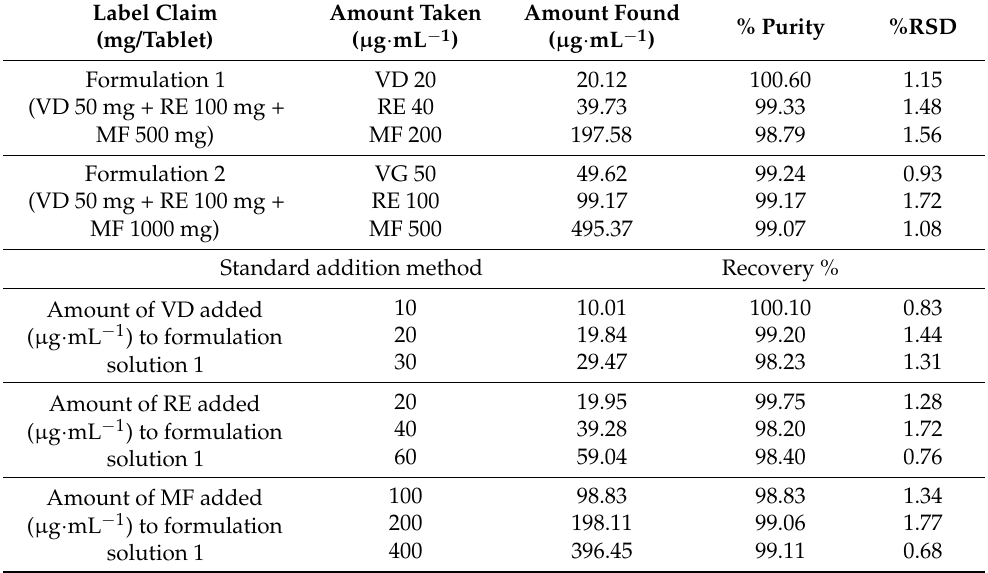
Table 5. Assay results of formulations and percentage recovery by standard addition